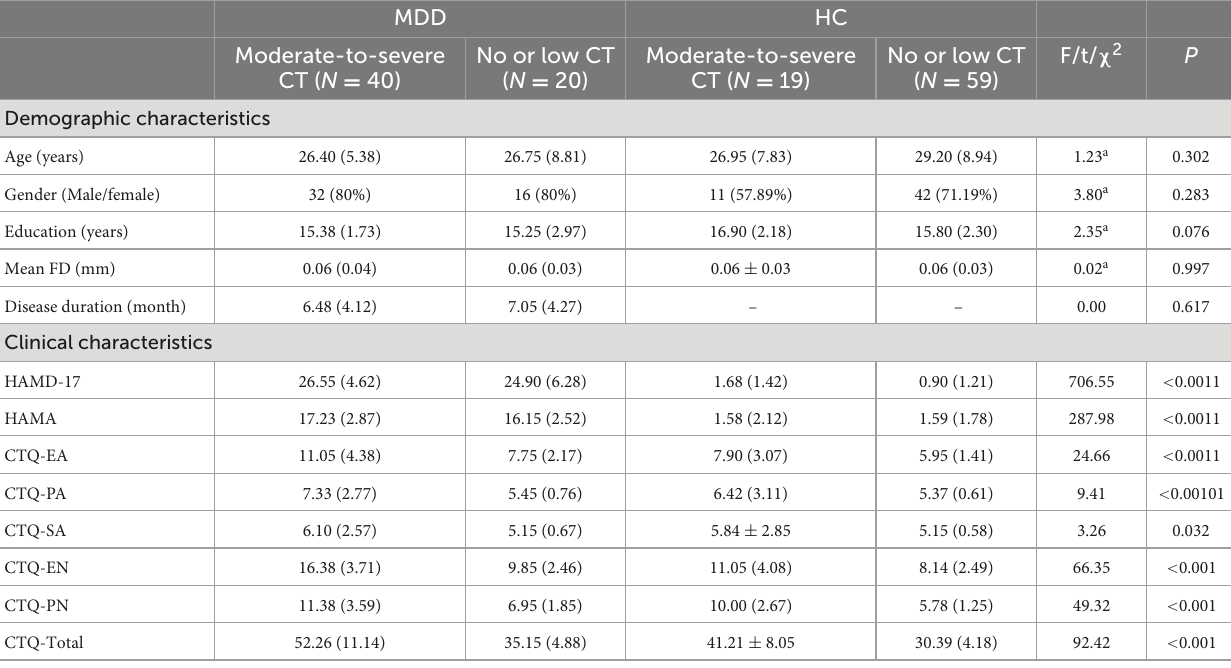
TABLE 1 Demographic and neuropsychiatric characteristics among four groups.